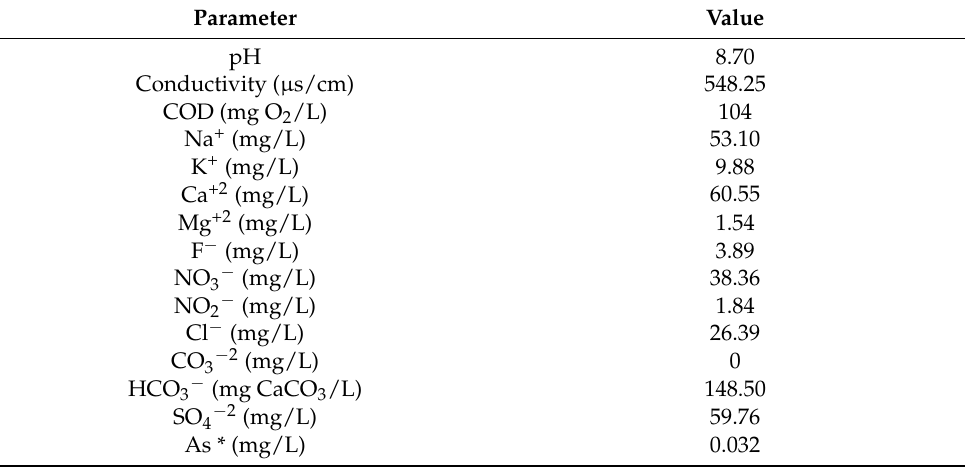
Table 1. Groundwater physicochemical characterization.